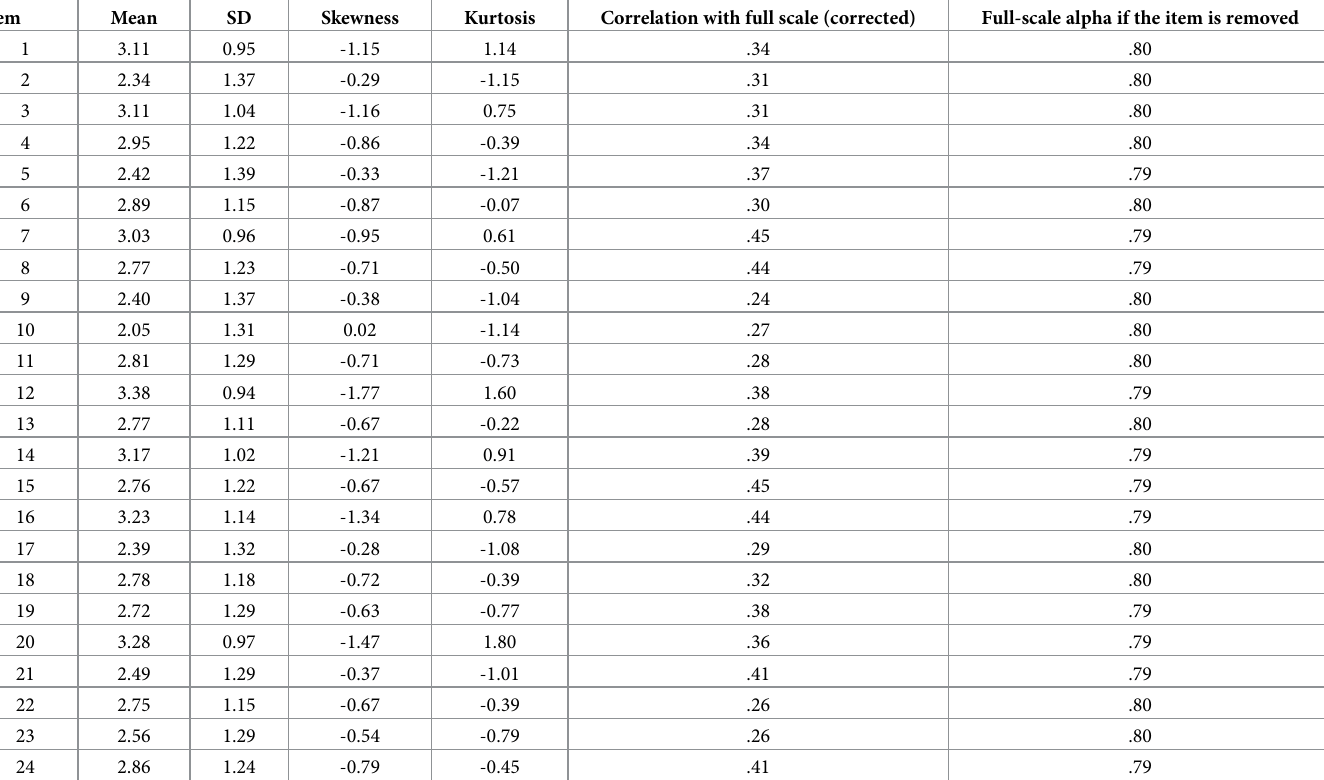
Table 3. GSAM item analysis. Mean, standard deviation, skewness, kurtosis of each item are presented. Likewise, each item’s Pearson correlation with the corrected full scale (excluding the item itself) and Cronbach’s alpha without considering the